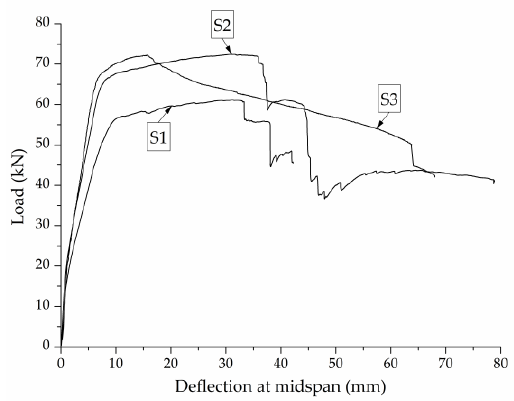
Figure 7. Load-deflection responses for experimental slabs. Table 4. Load and deflection response results for slabs.